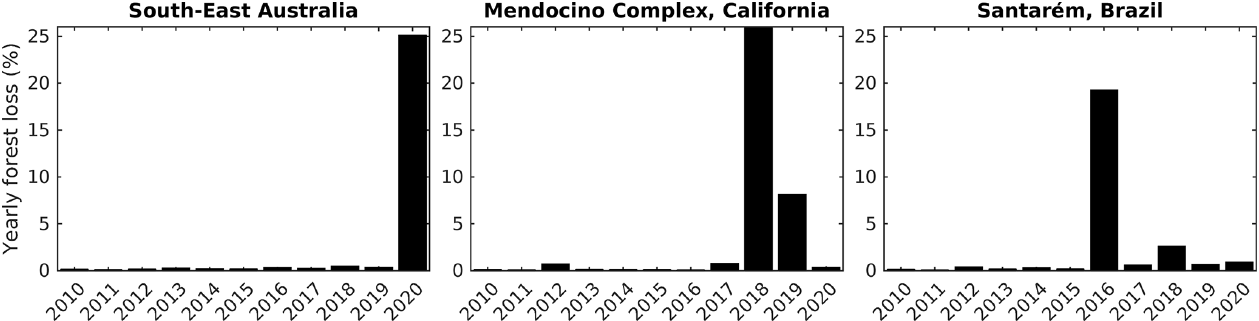
Figure 2. Yearly forest loss (%) attributed to the three burned areas under study, from the Hansen et al. (2013) “lossyear”